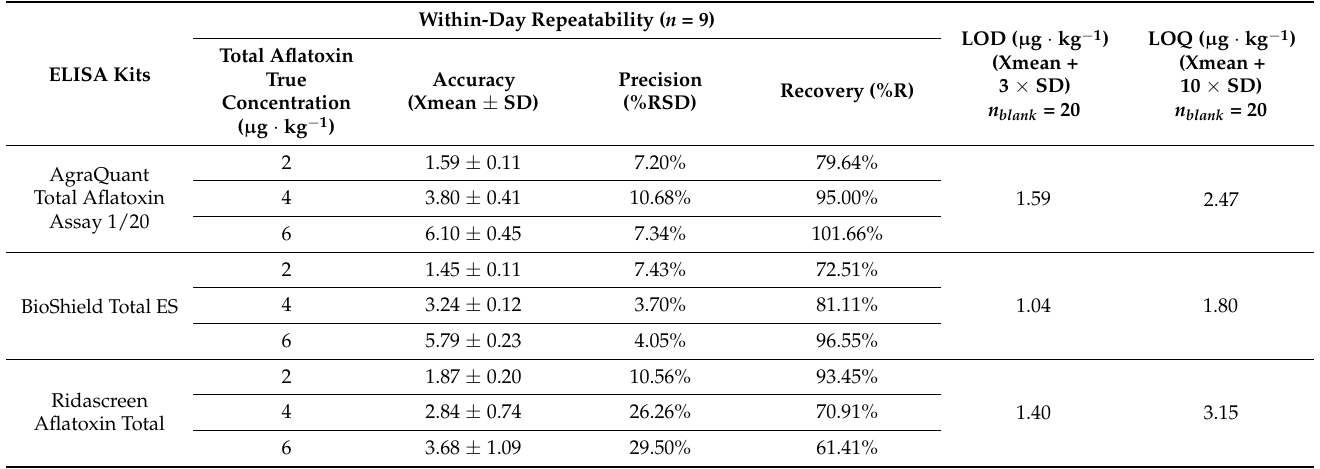
Table 2. Results from the comparative evaluation of the three commercial ELISA kits for the detection and quantification of AFB1, AFB2, AFG1, and AFG2 in